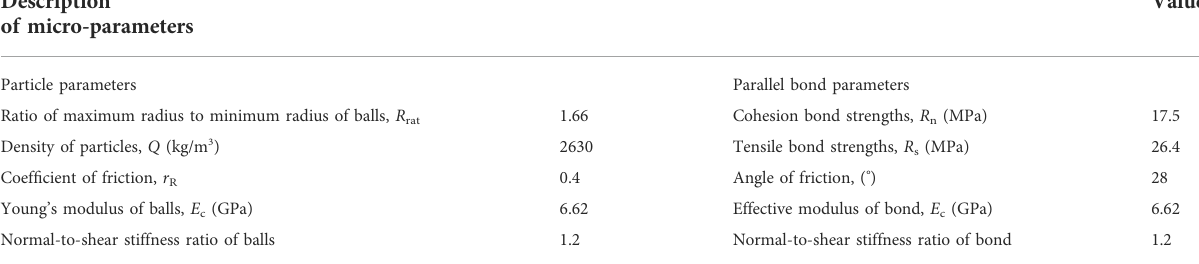
TABLE 4 Micro-parameters for bond parallel contact